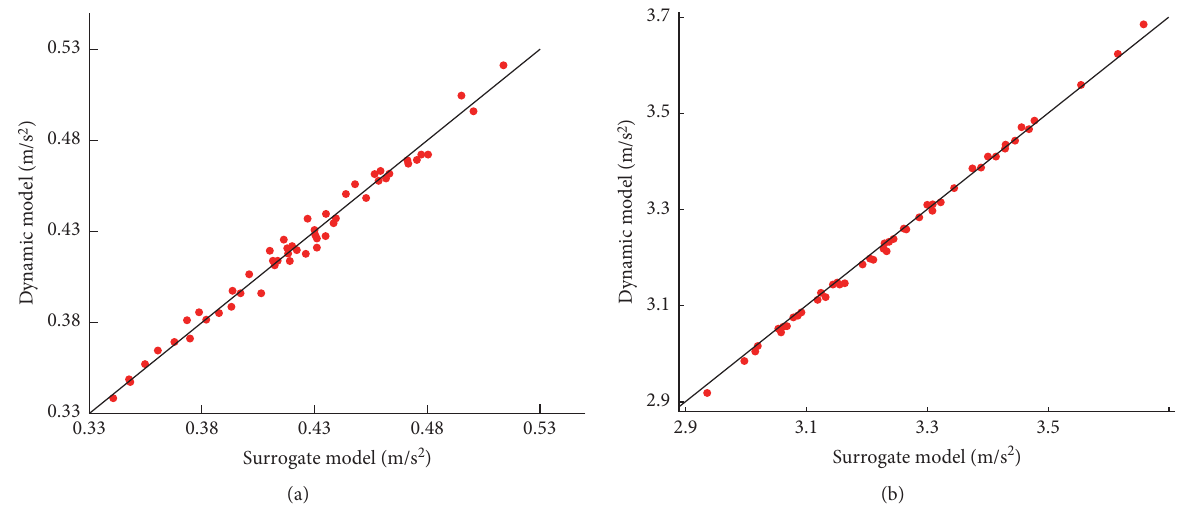
Figure 8: Comparisons between prediction of the RSM and calculation of the dynamic model of (a) the human body and (b) the carriage.